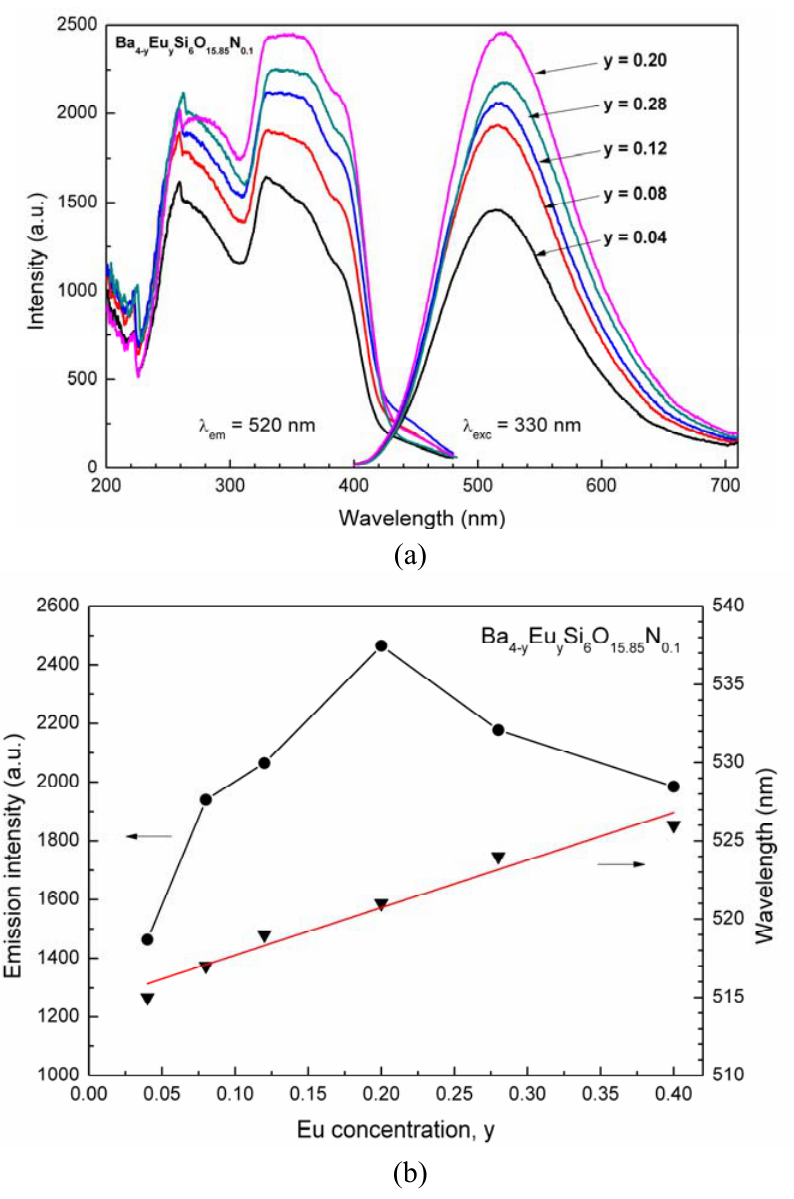
Figure 8. Excitation and emission spectra of Ba relationships between emission intensity and wavelength with the Eu 2+ concentration